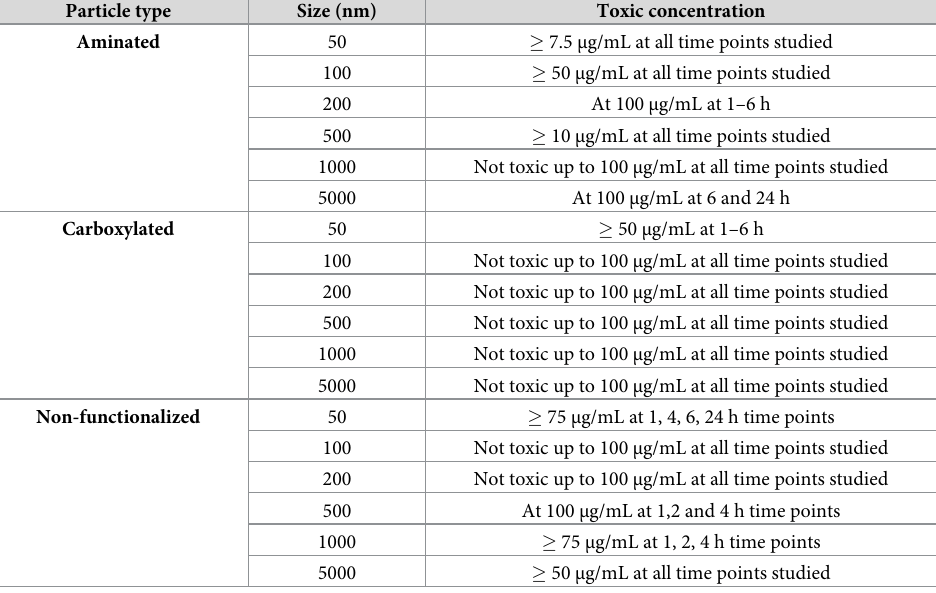
Table 4. Concentrations of particles that caused significant decreases in the viability of SNU-1 cells compared to untreated cells during 1, 2, 4, 6 or 24 h treatment periods. Particle type